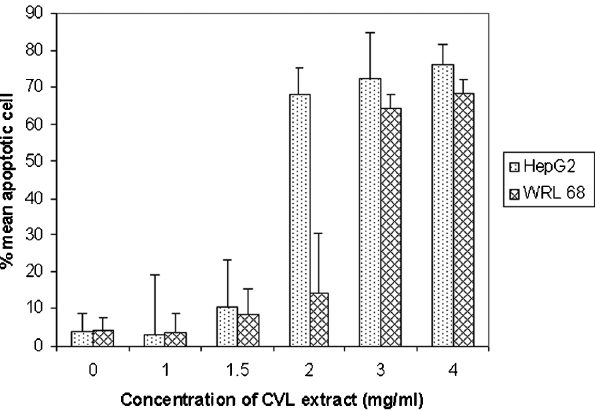
Figure 4 - Effect of Chlorella vulgaris on the protein expression of P53, Bax, caspase-3 and Bcl-2. Chlorella vulgaris at 2 mg/ml (optimal dose) induced higher expressions of P53 (a), Bax (c) (proapoptotic) and caspase-3 (d) proteins in HepG2 cells compared to the control cells after 24 hours treatment. Mean- while, Bcl-2 (b) (antiapoptotic) protein expression was reduced compared to the control cells. No significant changes in the expressions of caspase-8 (e) proteins in hepatoma cells treated with C. vulgaris (2 mg/ml) were observed after 24 hours of treatment. CVL = Chlorella vulgaris